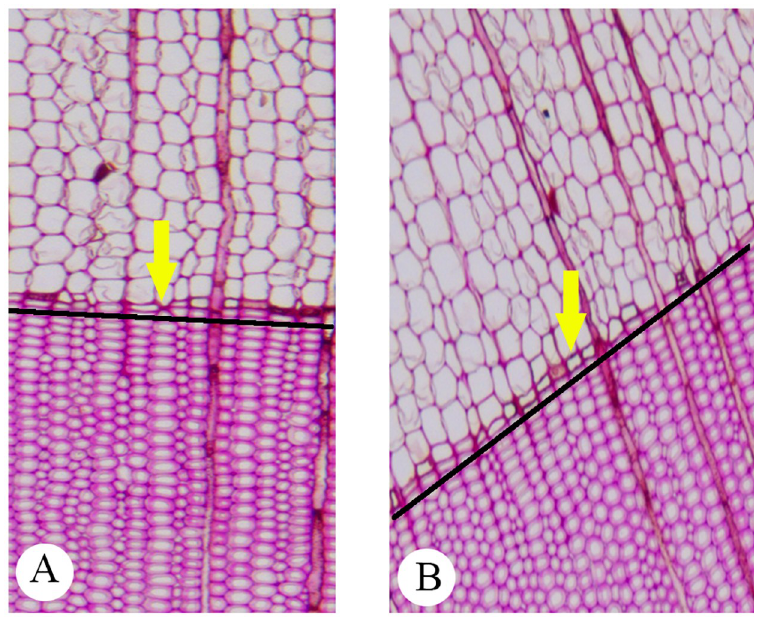
Fig 4. Examples of imported images of local regions: -a: Suitable image. -b: Unsuitable image.